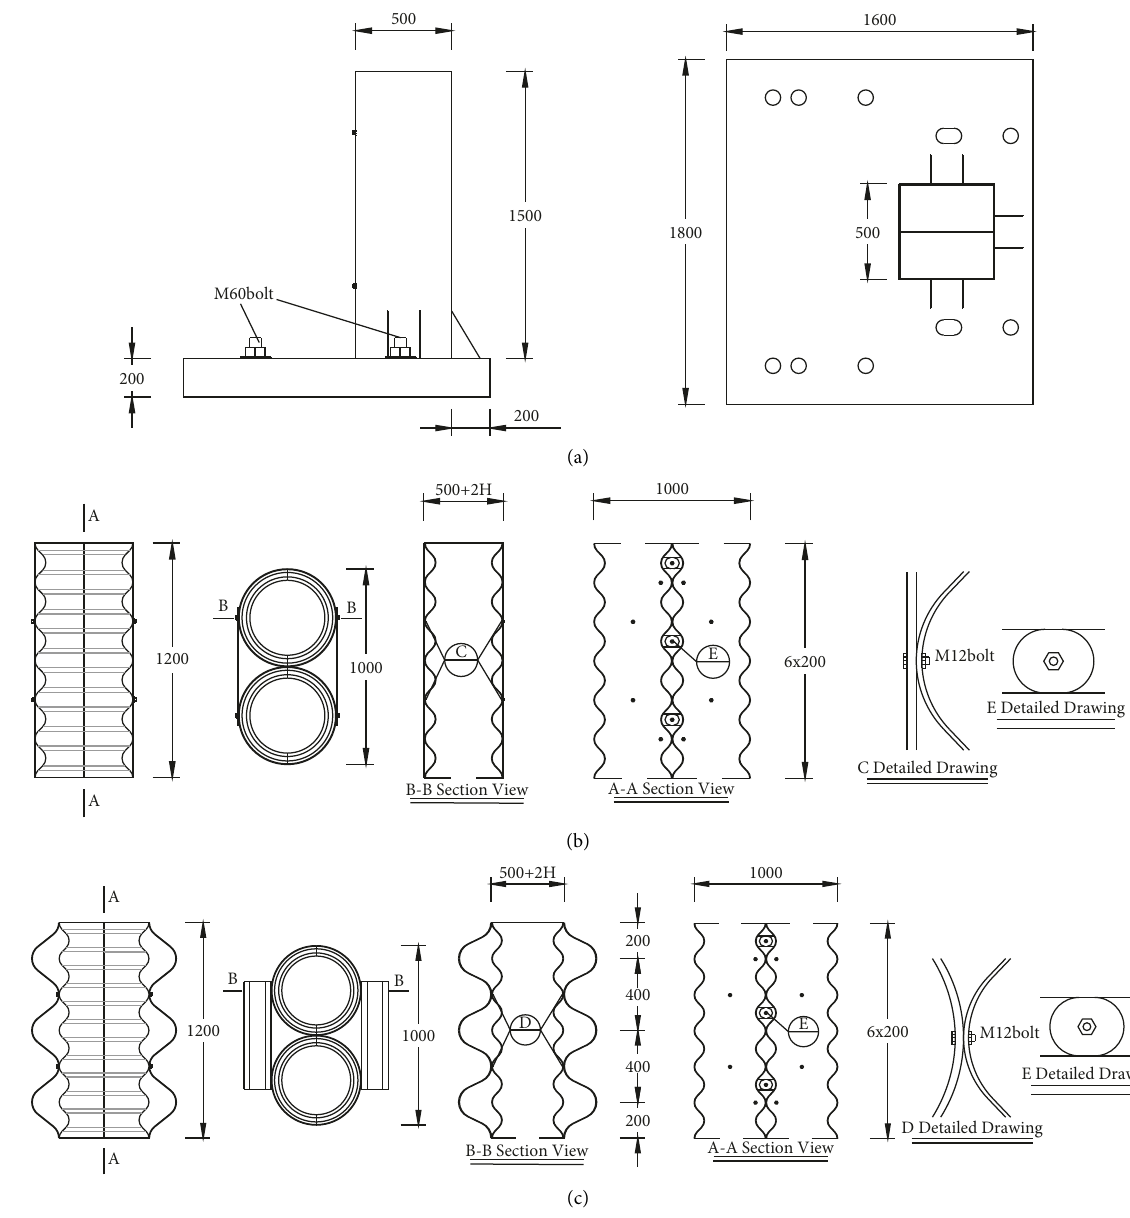
Figure 1: Geometry of the specimen (unit: mm). (a) CWACF-12.0 specimen geometry. (b) OSP specimen geometry. (c) CSP specimen